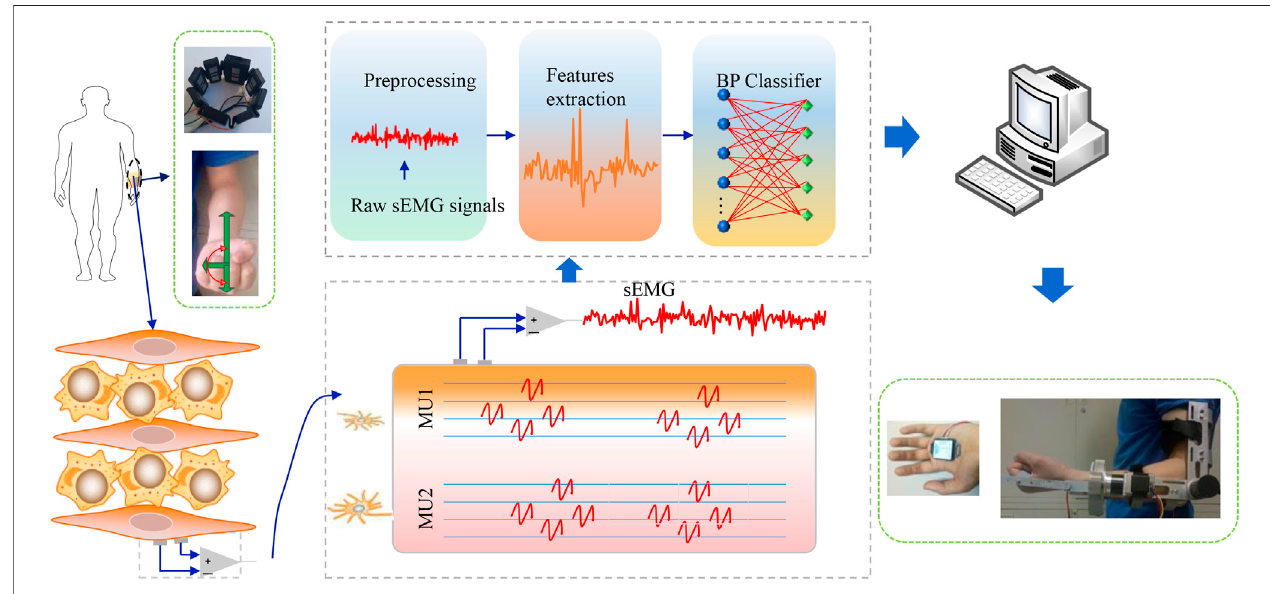
FIGURE 7 | Experimental fl ow of controlling the exoskeleton robot.